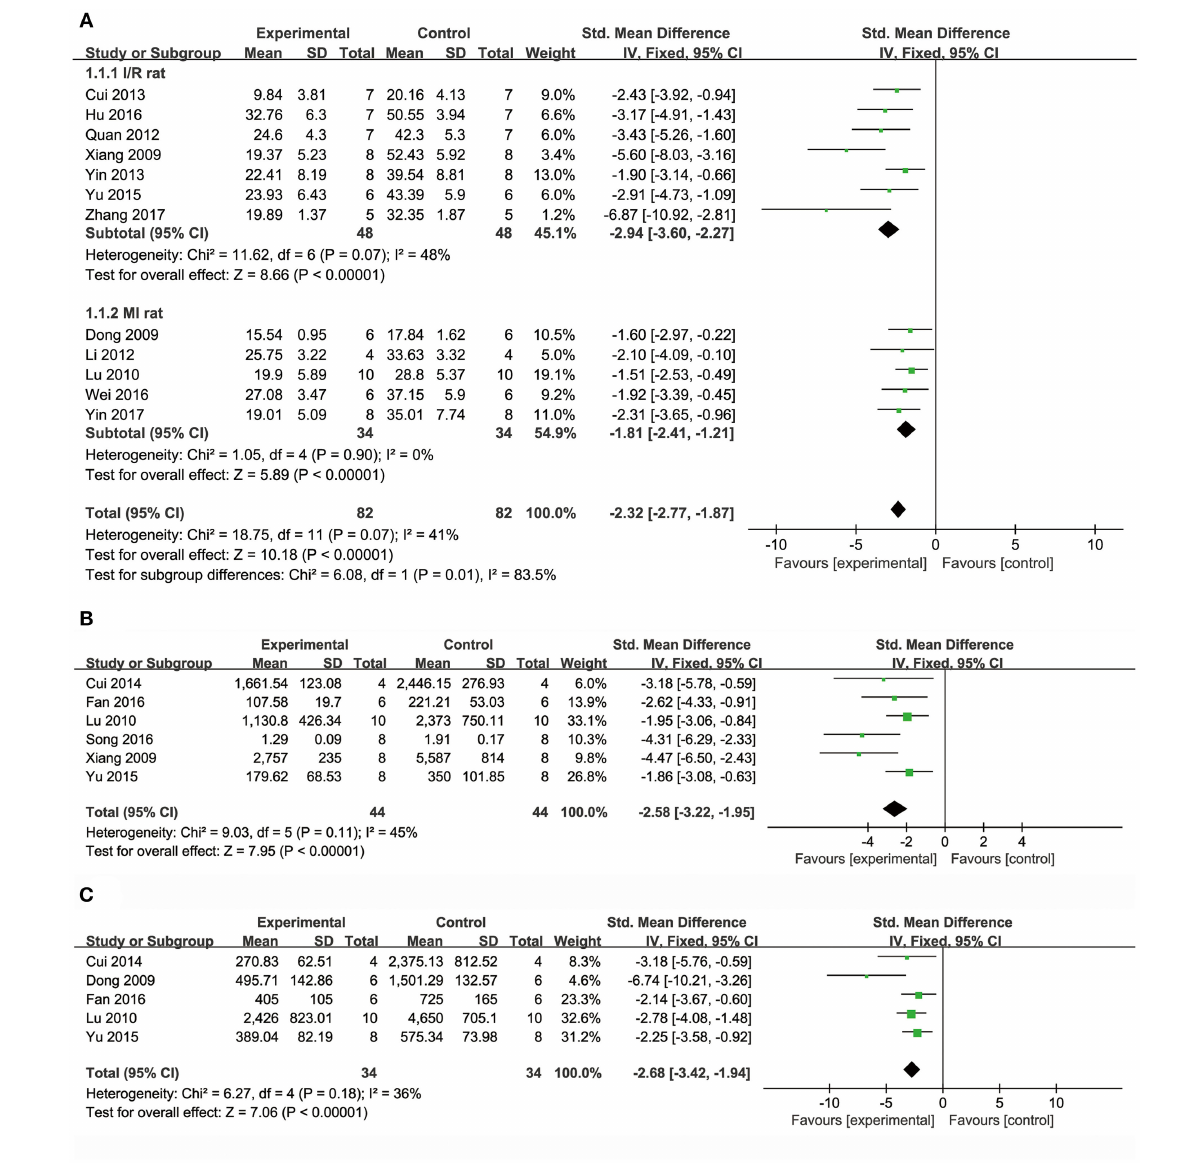
FIGURE 2 | The forest plot: (A) in vivo effects of danshensu on reducing myocardial infarction size compared with controls ( n = 82 per group); (B) in vivo effects of danshensu on reducing LDH compared with controls ( n = 44 per group); (C) in vivo effects of danshensu on reducing CK compared with controls ( n = 34per group). LDH, lactate dehydrogenase; CK, creatine